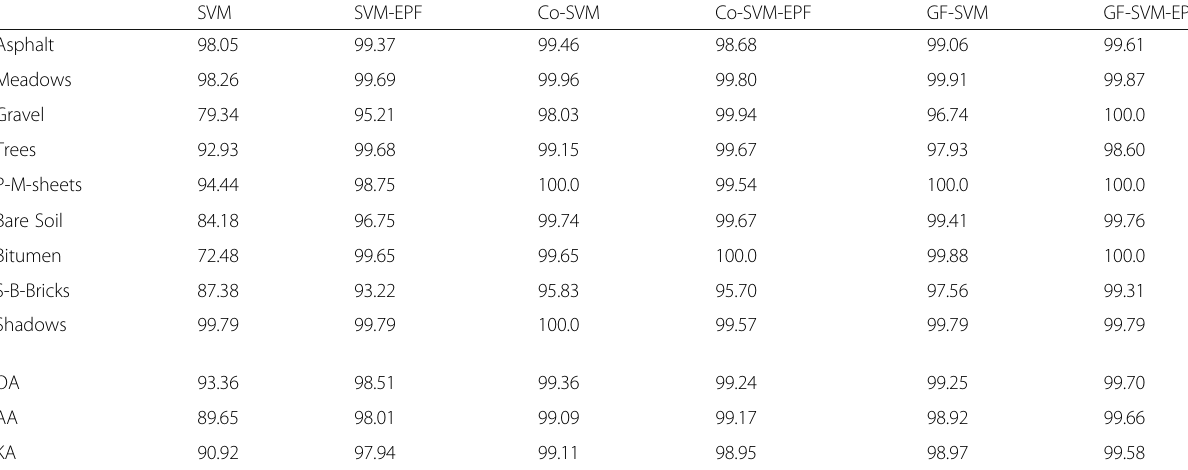
Table 2 Classification accuracy on the University of Pavia dataset (10% samples for training) SVM Asphalt